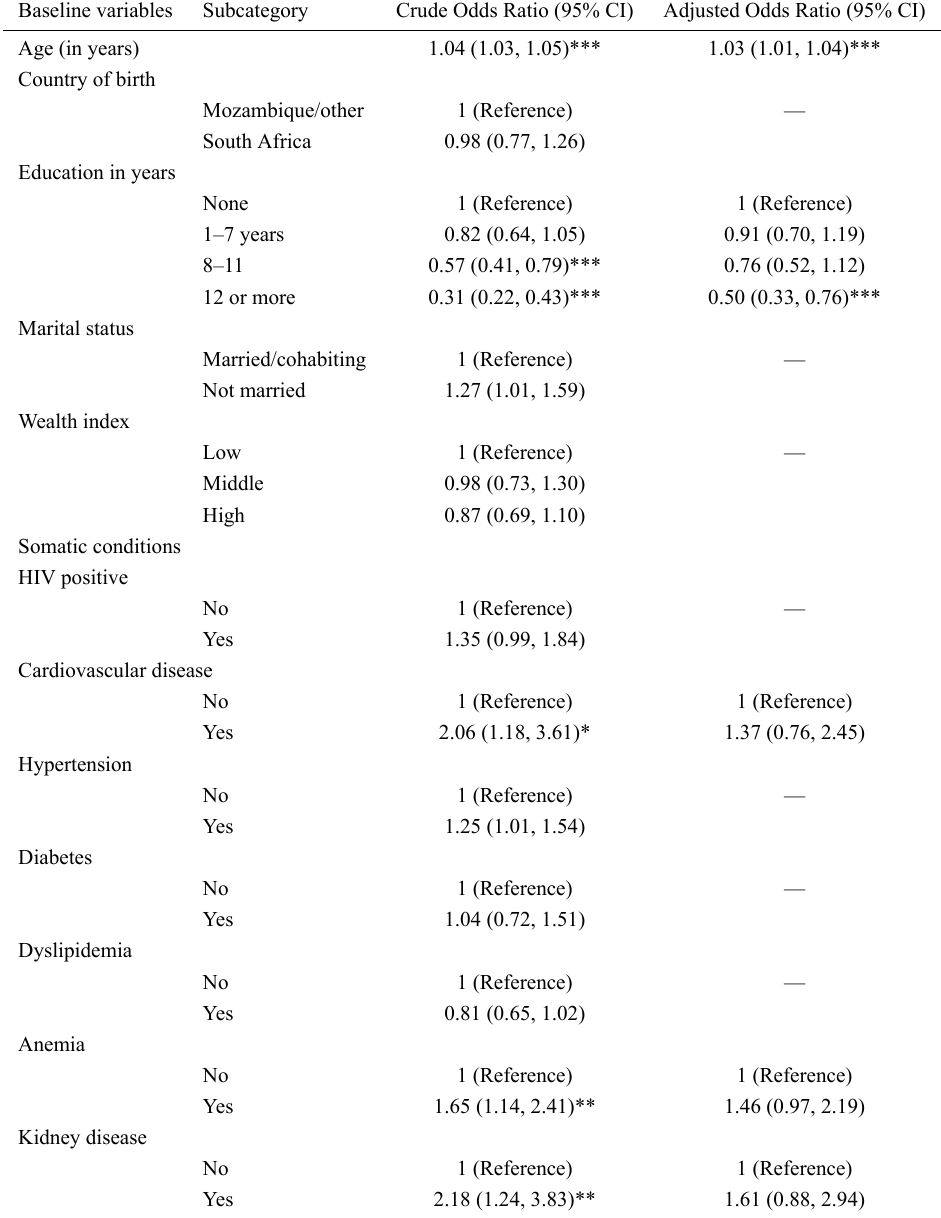
Table 4. Odds ratios for the association between chronic conditions, lifestyle factors and incident low life satisfaction among men 40 years and older, HAALSI